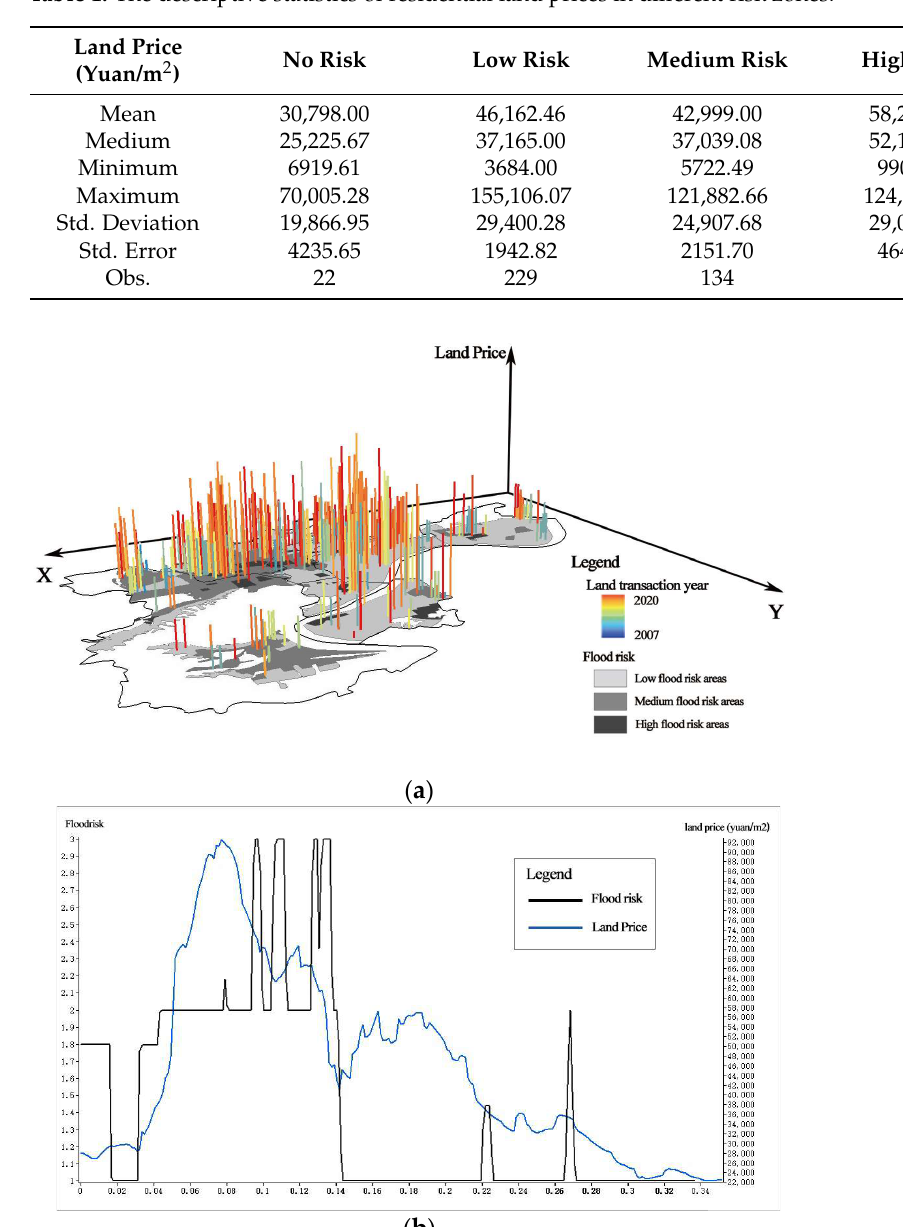
Table 1. The descriptive statistics of residential land prices in different risk zones.